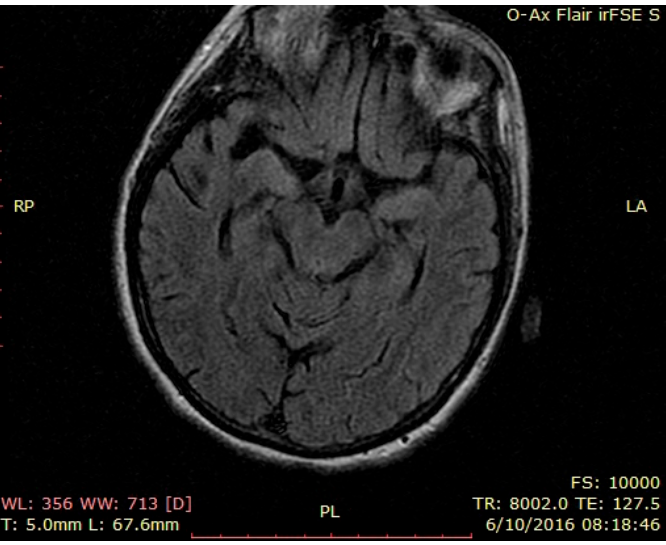
Figure 4. Second brain MRI, FLAIR images, axial temporal image.